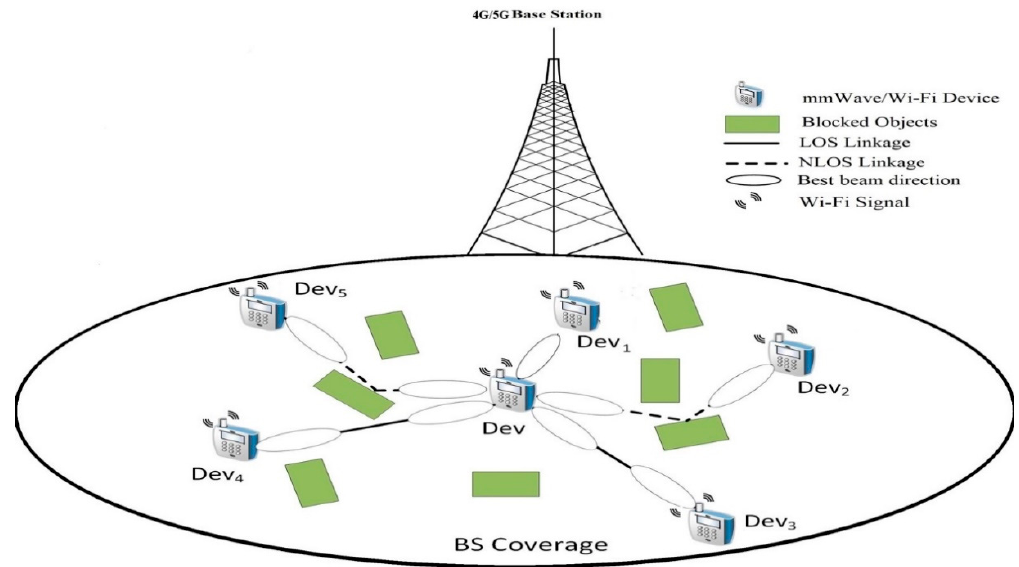
Figure 1. Multi-band D2D network architecture.